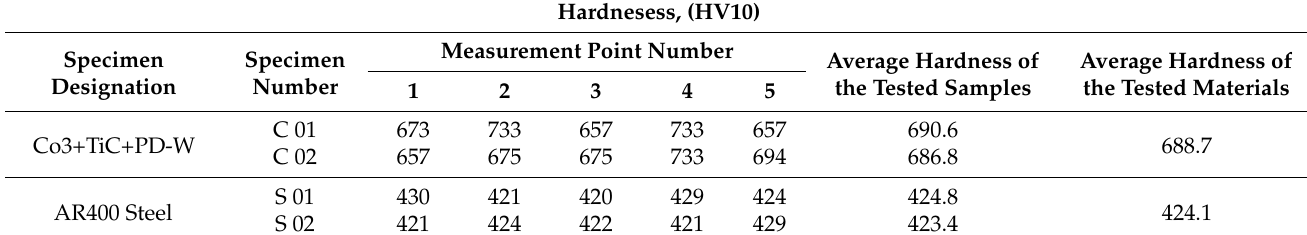
Table 6. Hardness (HV10) measurement results concerning the external surface of the layer (PPTAW metal deposition method, Co3+TiC+PD-W composite powder) deposited on structural low-alloy steel AISI 4715 and of the surface of the reference material (abrasion-resistant steel AR400).